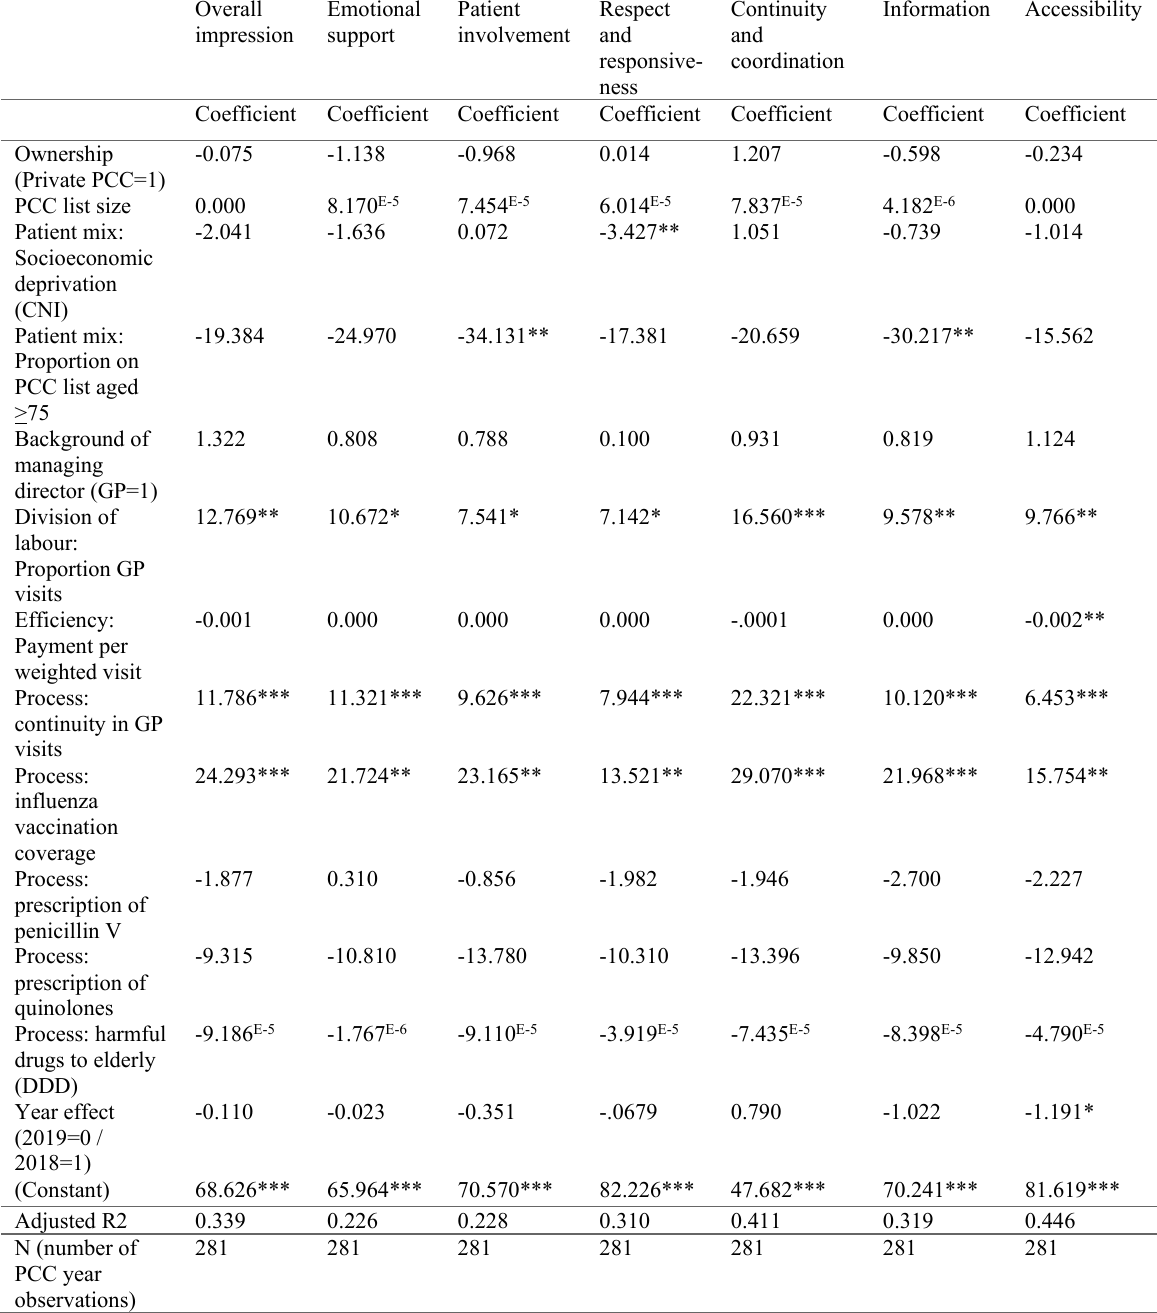
Table 3: Regression models with PREMs as dependent